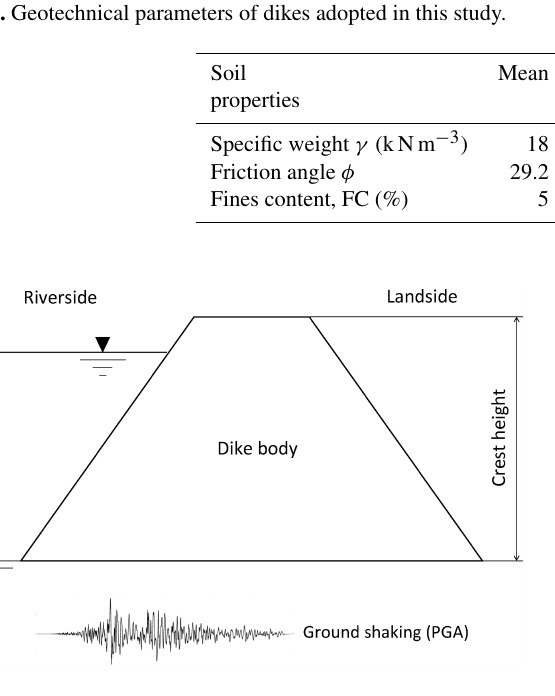
Figure 2. Generic dike model to illustrate the earthquake–flood– dike